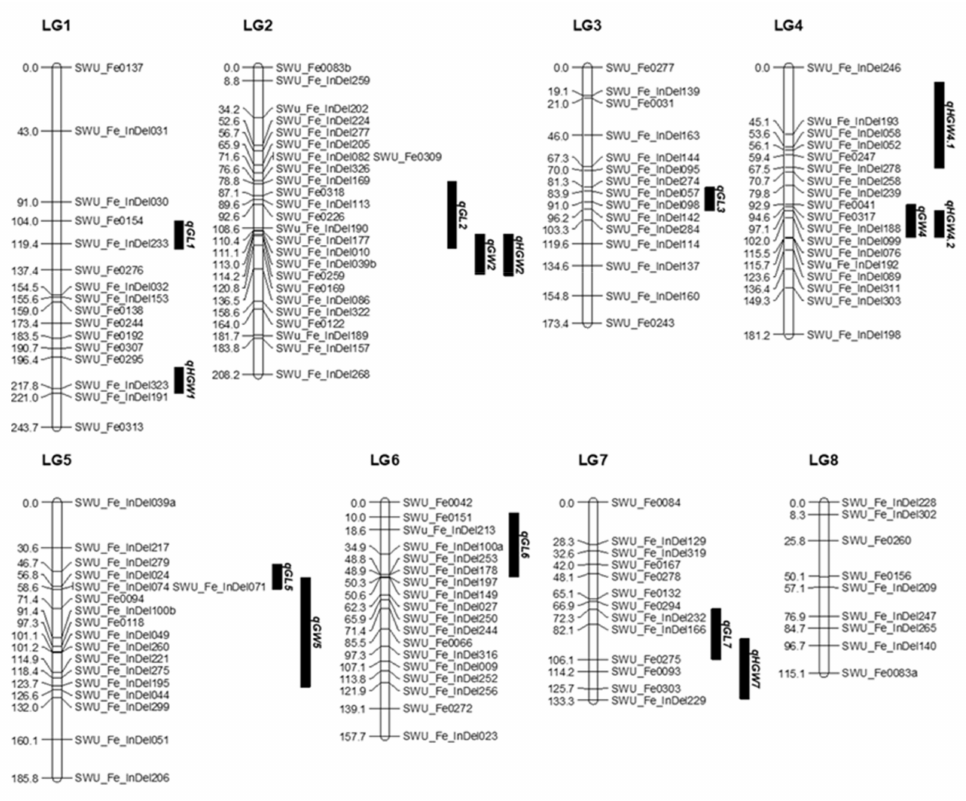
Figure 4. The Genetic linkage map and QTL controlling grain size traits from (UD × YQ2) F 1 population. The QTL controlling grain size traits and the bars representing 1-LOD likelihood intervals are beside the linkage group. QTL is shown as GL for grain length, GW for grain width, and HGW for hundred-grain